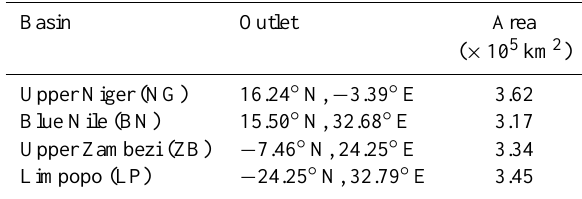
Table 1. Basin definitions. See also Fig.